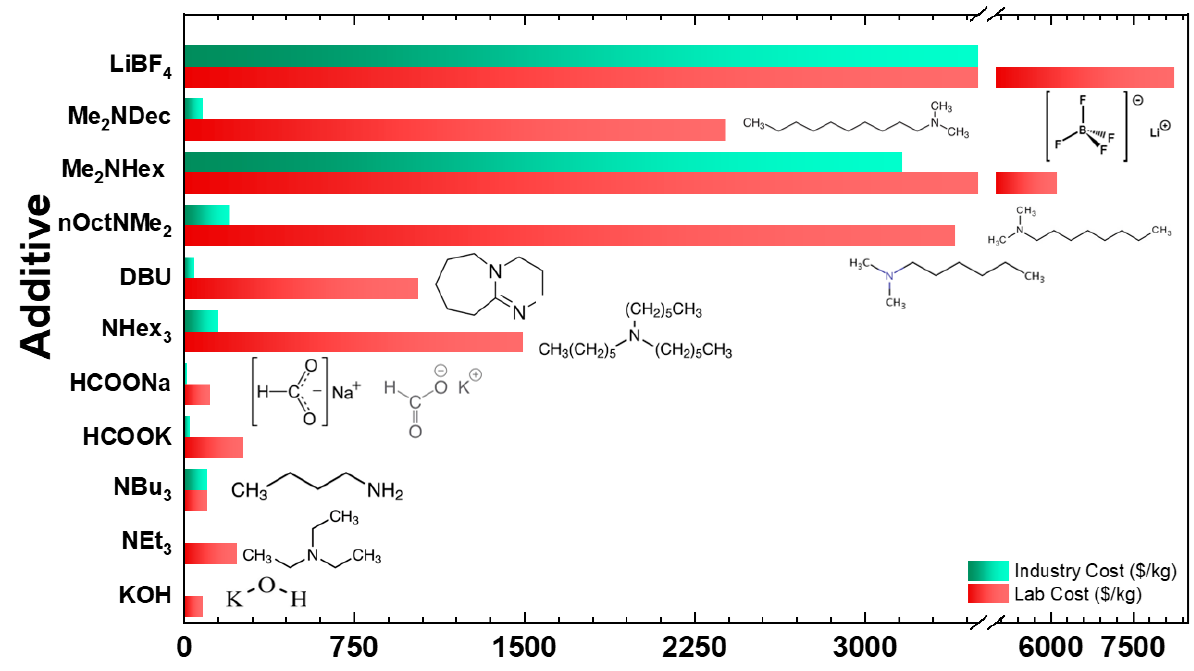
Figure 13. Lab-scale vs. industrial-scale cost of selected additives used for FA dehydrogenation. Table 3. Cost analysis based on the The cost of using formate salts, is low compared to other additives, with HCOONa being the cheapest ($14 per kg), while HCOOK is costlier at $27 per kg. At lab-scale cost, the prices are 10 times higher with 116 $/kg and 264 $/kg, respectively. Among various systems [54,73,111] or replacing the formate salts. Interestingly, in a Mn(pyridine-